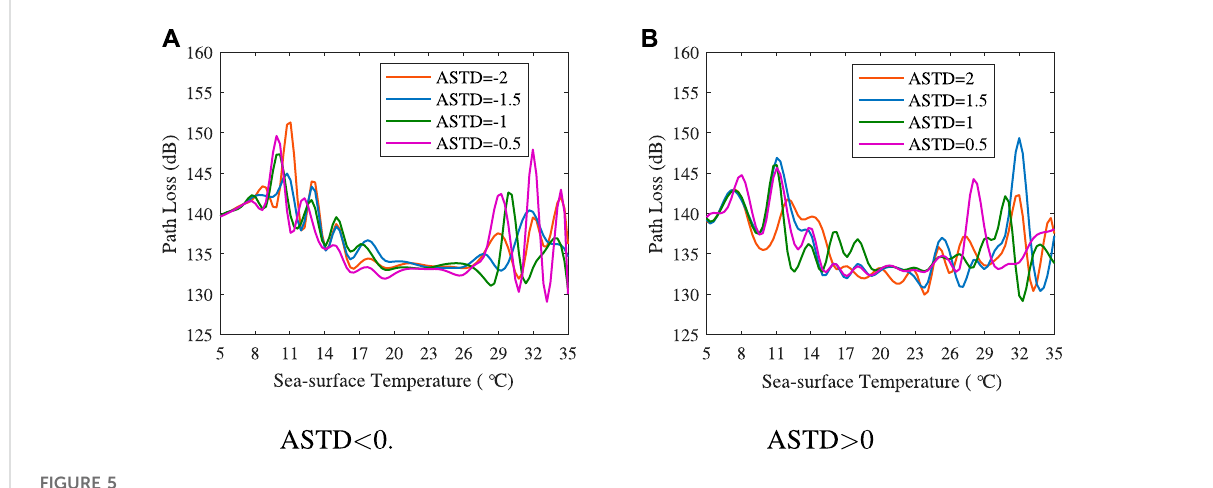
FIGURE 5 In fl uence of temperature on path loss under different ASTD. (A) ASTD < 0. (B) ASTD >